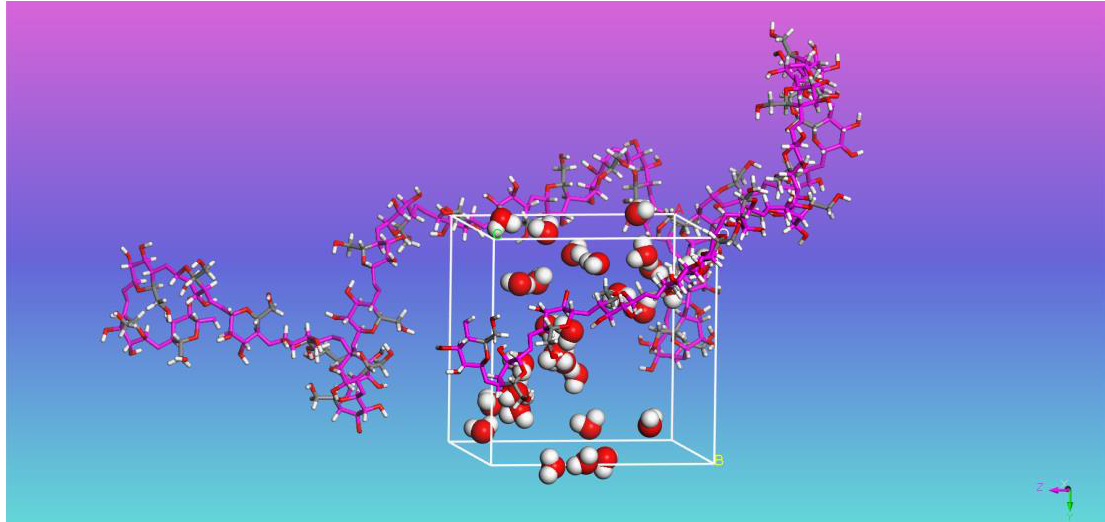
Figure 1. The amorphous cellulose region – water molecule model .